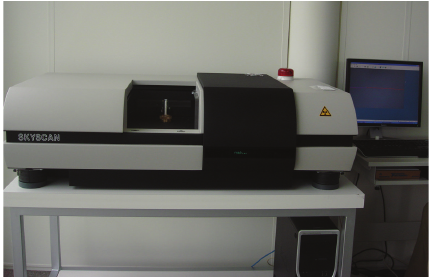
Figure 5: The photograph of the micro-CT scanner.